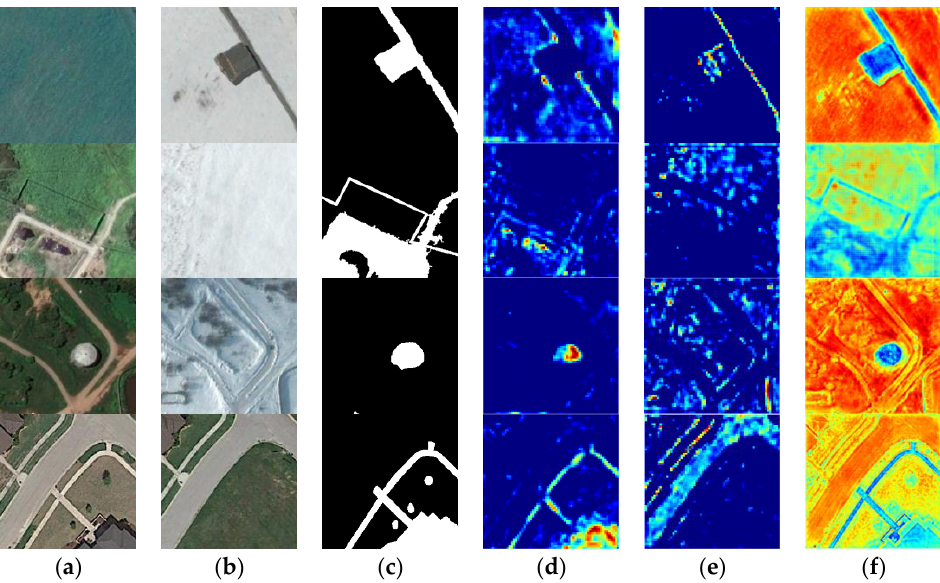
Figure 13. The heatmaps after the final ASPCA module: ( a ) Image T1. ( b ) Image T2. ( c ) ground truth. ( d ) The heatmap of feature T1. ( e ) The heatmap of feature T2. ( f ) The heatmap of fused feature after ConvTransposed Block 1.